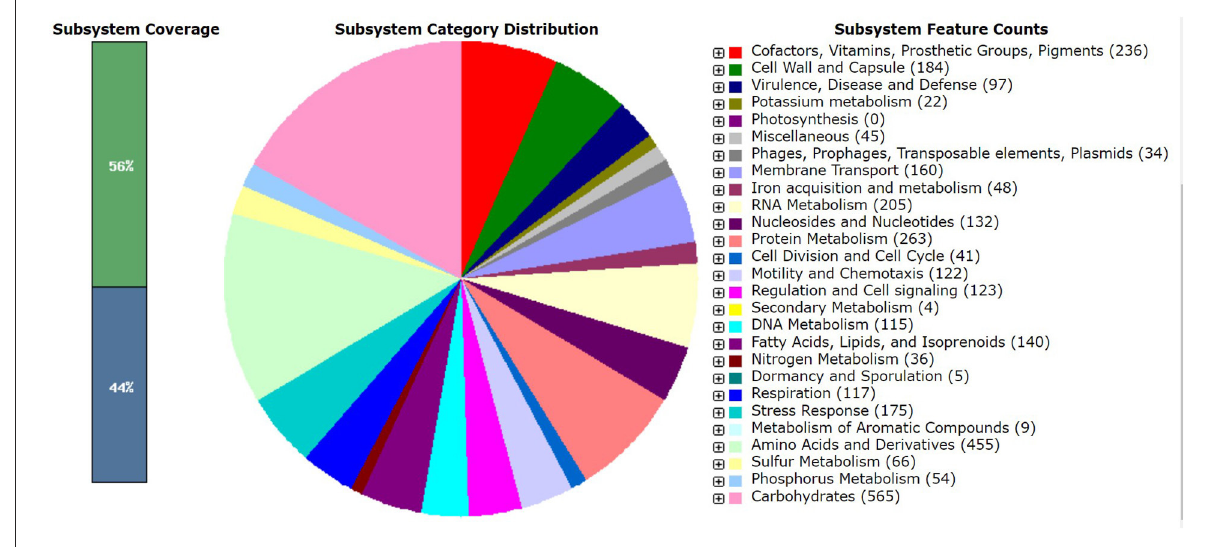
FIGURE1 RAST annotations of Pantoea agglomerans CPHN2 whole genome.